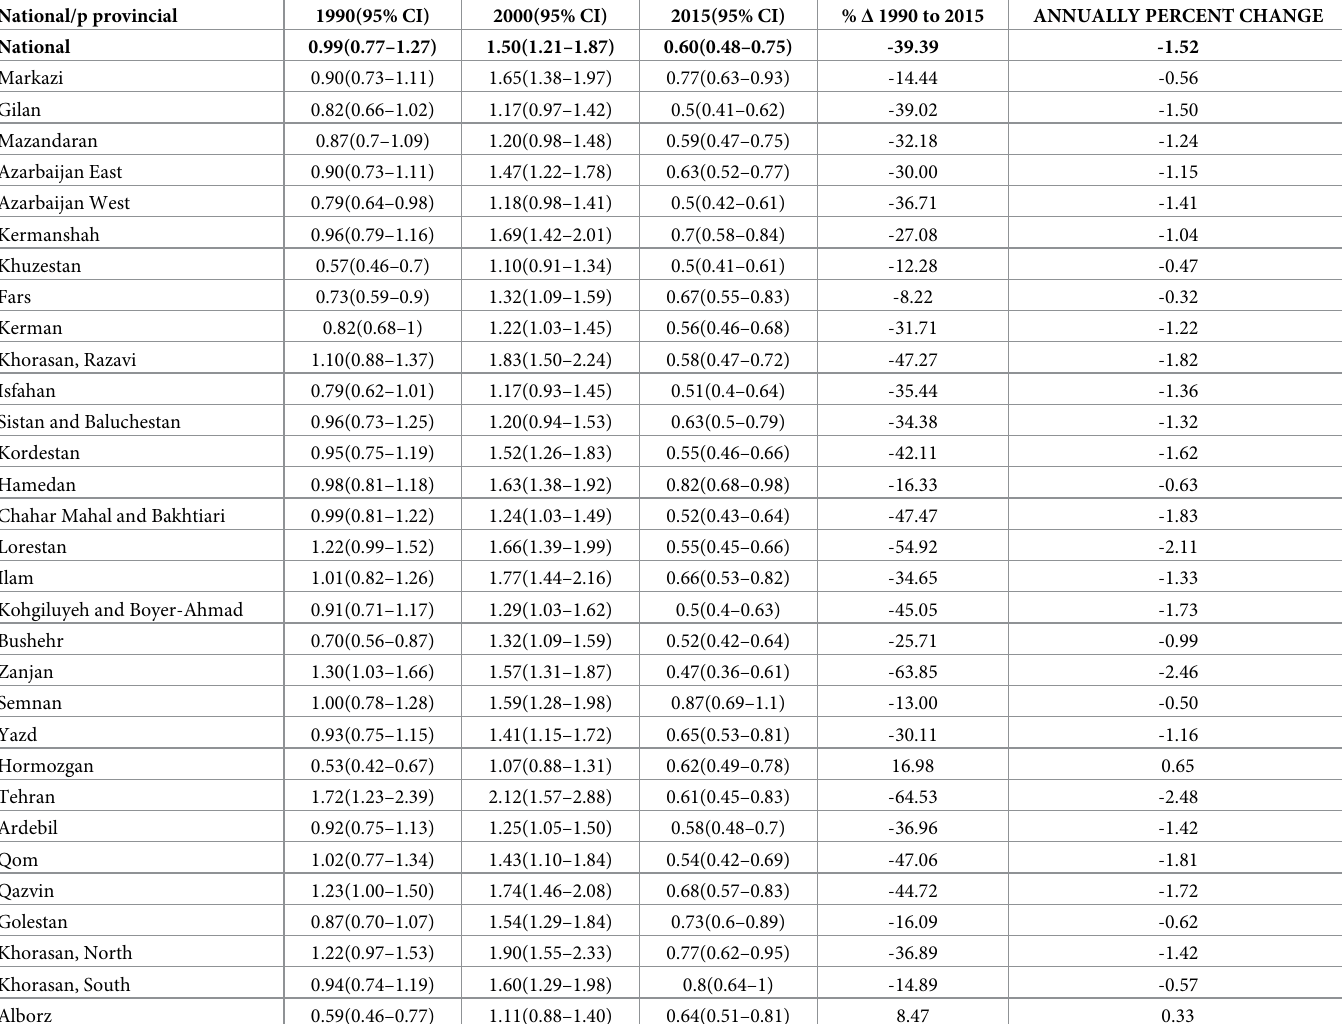
Table 1. National and provincial age standardized mortality rate in Iran (per 100,000) for both sexes and the percentage of change ( Δ